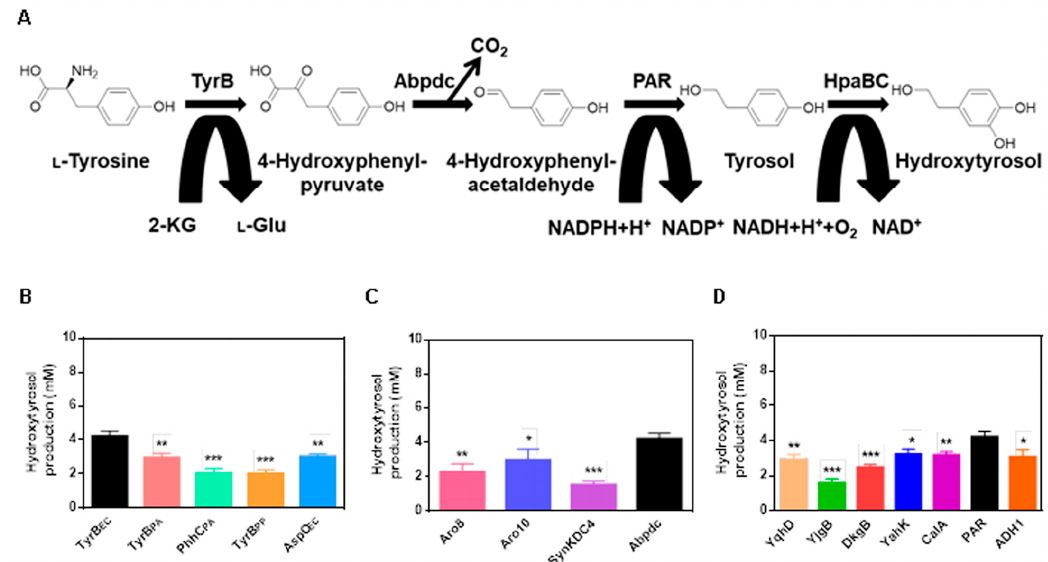
Figure 1. Production of hydroxytyrosol from tyrosine by whole-cell bioconversion. ( A ) Biosynthesis of hydroxytyrosol from tyrosine via the designed pathway. ( B ) Production of hydroxytyrosol by strains with different aminotransferases. ( C ) Production of hydroxytyrosol by strains with different 4-hydroxyphenylpyruvate decarboxylases. ( D ) Production of hydroxytyrosol by strains with different reductases. 10 mM tyrosine was supplemented as substrate. Data are expressed as the mean ± SD ( n = 3). * p < 0.05, ** p < 0.01 and *** p < 0.001, compared to each control.